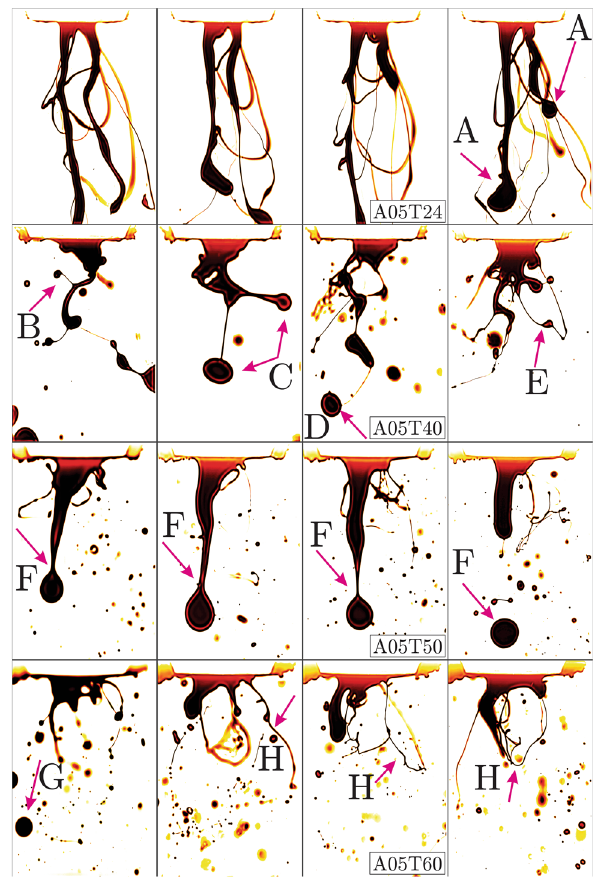
Figure 2. Bio-oil injected at the preheating temperatures T = 24, 40, 50, 60 ( ◦ C) ( T 24, T 40, T 50 and T 60 cases), liquid q f = 1.8 (kg/h) ( L 04 cases at 4 (lb/h)) and air flow rates of q a = 5 (l/min) ( A 05 cases). (FOV: × 14.15 d 9.43 d a a